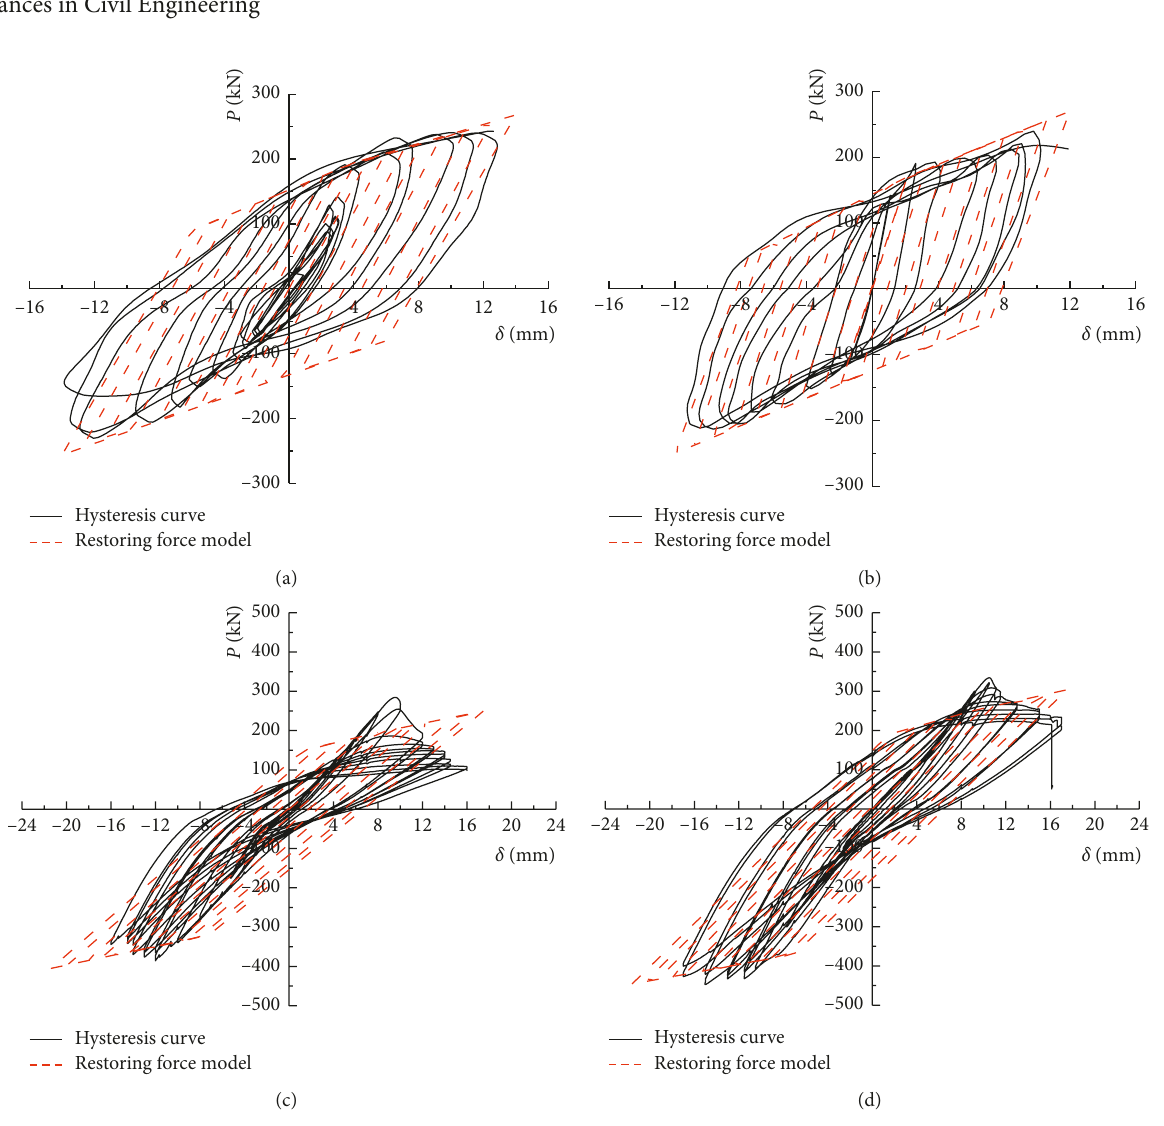
Figure 12: Restoring force model of the joints. (a) K-RC, (b) K-CC, (c) K-RC1, and (d)